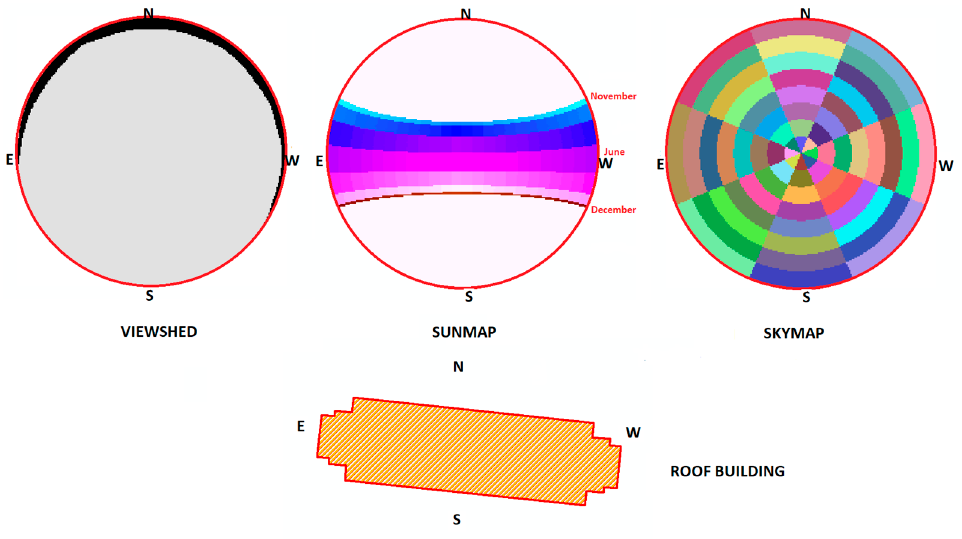
Figure 5. Viewshed, sunmap, and skymap on the roof of the case-study building.